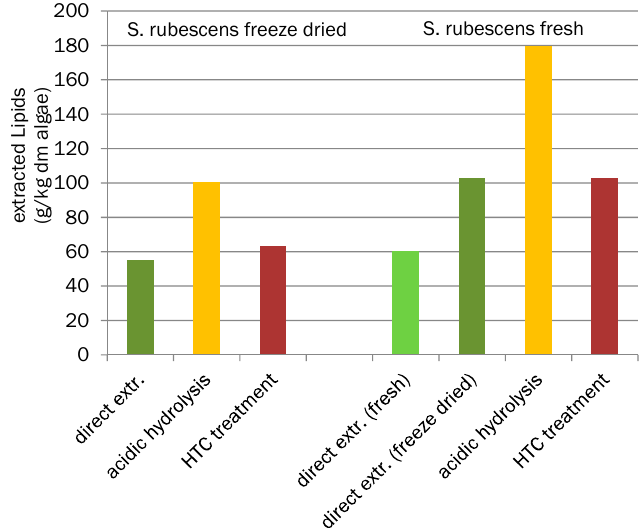
Figure 1. Extraction yields for fresh and freeze-dried S. rubescens at different pretreatments. The lipid yields extracted from the fresh S. rubescens did vary in absolute measures from the yields of the freeze-dried S. rubescens . The reason for this can be found in seasonal differences and different bioreactor setups. Therefore, the absolute measures of the two charges can not be compared.